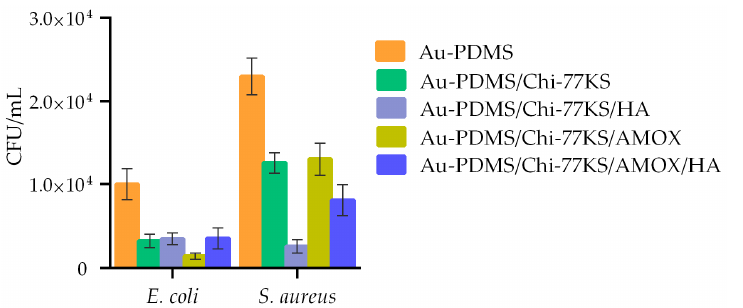
Figure 11. Attachment of E. coli and S. aureus and early biofilm formation on samples Au-PDMS, Au-PDMS/Chi-77KS and Au-PDMS/Chi-77KS/AMOX [35], and samples with an additional HA layer (Au-PDMS/Chi-77KS/HA and Au-PDMS/Chi-77KS/AMOX/HA) after 24 h of